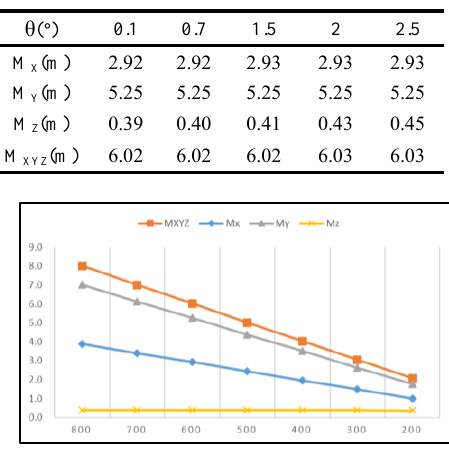
Figure 2. Influence of the flight altitude